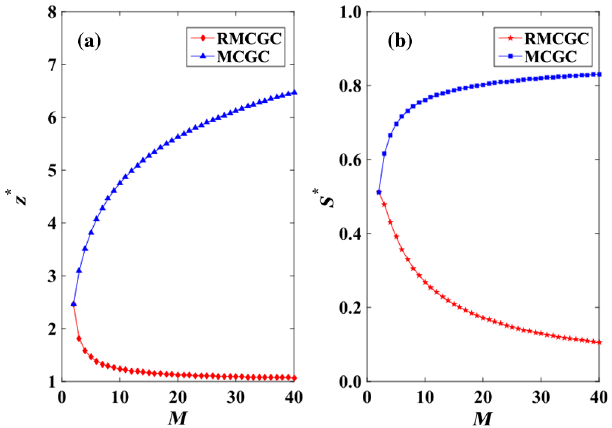
FIG. 5. Comparison between the MCGC and the RMCGC models in Poisson multiplex networks. (a) Critical value z ⋆ of the average degree as a function of the number of network layers M . Results for the RMCGC model are displayed as red diamonds. Results for the MCGC model are denoted by blue triangles. (b) Height of the jump S ⋆ at the transition point as a function of the number of network layers.